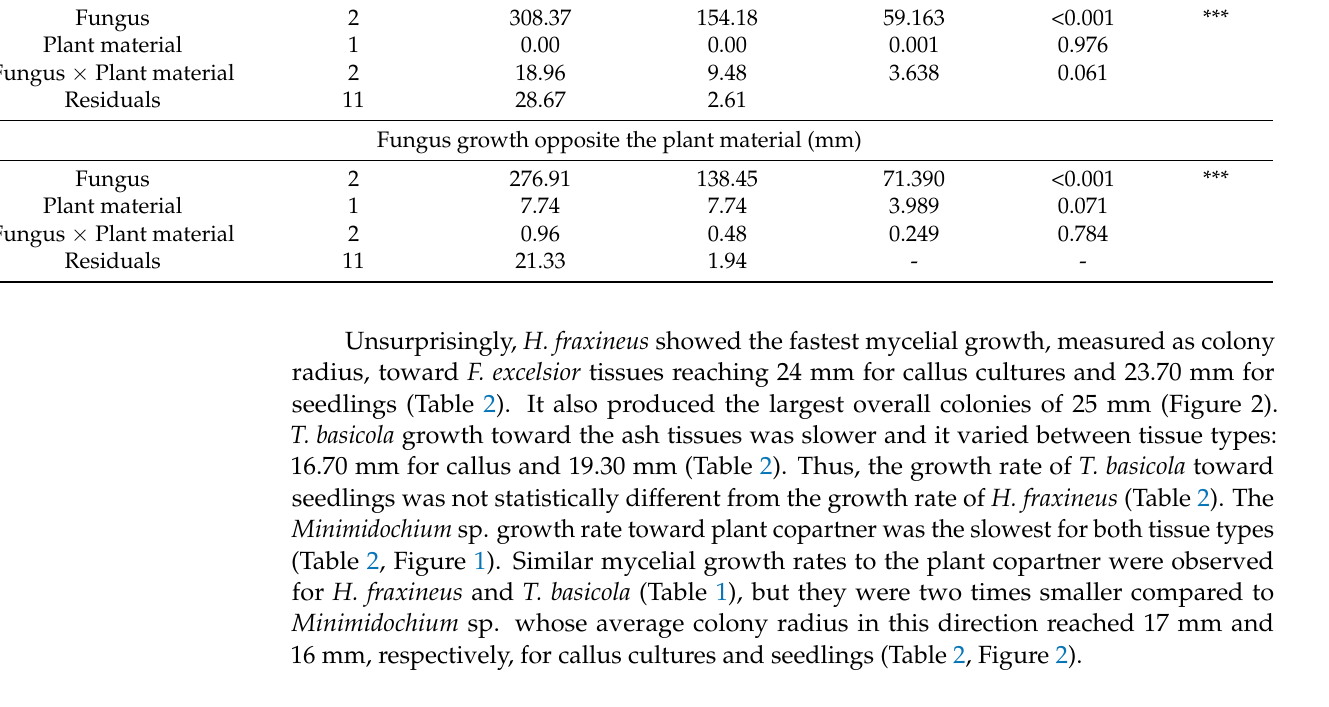
Table 2. The Average fungal growth of the analyzed fungi. The same letters indicate the lack of statistically significant differences ( p < 0.05), only the letters marked with the same number should be